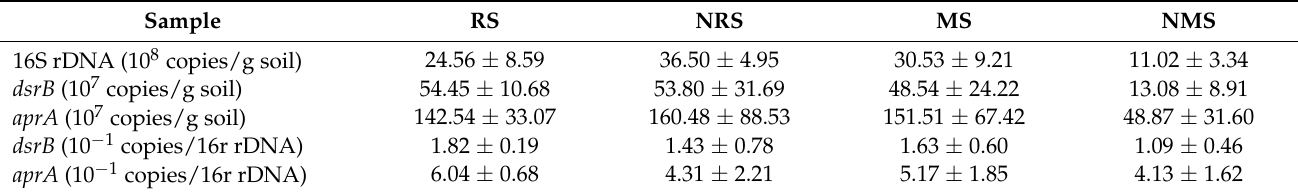
Table 2. Quantitative polymerase chain reaction results of subtropical mangrove sediments in the Beibu Gulf.